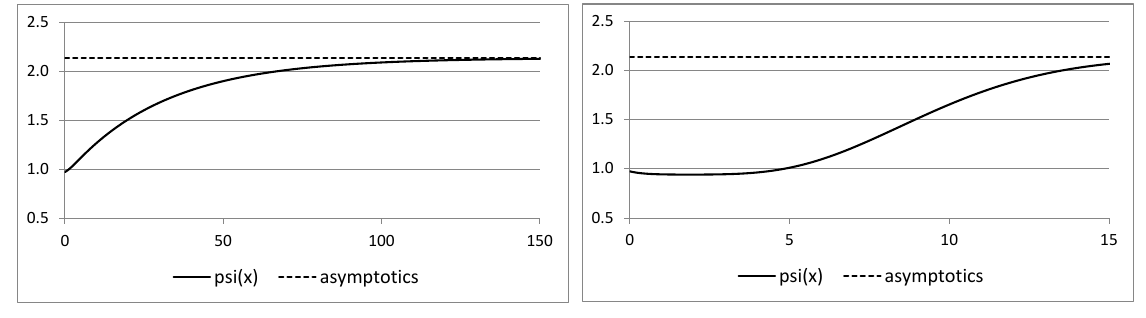
Figure 1. Function x (cid:55)→ ψ ( x ) for parameters r Example 2 with c = 1 ; rhs: Gaussian Example 3 with µ = 4